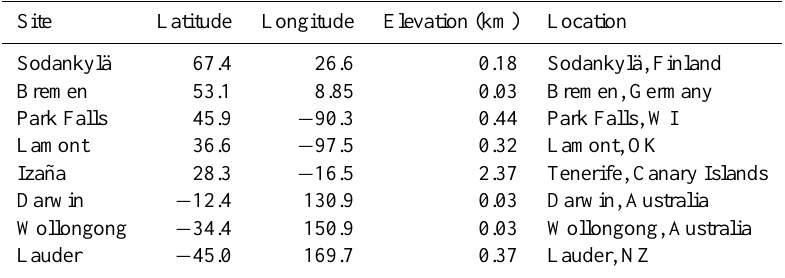
Figure 3. Validation of the tropospheric column-averaged CH 4 derivation using HF as a proxy. The calculated tropospheric CH 4 ( y axis) uses the TCCON priors, CH 4 averaging kernel and ACE-FTS vertical profiles to determine the value that the ground-based FTS would retrieve. The integrated tropospheric CH 4 ( x axis) applies the pressure-weighting function and TCCON CH 4 averaging kernel and priors to the extrapolated tropospheric ACE-FTS profile of CH 4 . The black lines depict the one-to-one line (solid) and the linear regression of the calculated vs. integrated tropospheric CH 4 with a zeroed y intercept (dashed). The r 2 values correspond to the linear regression. Note the different DMF ranges in the Northern vs. Southern Hemispheres. Table 2. TCCON sites, coordinates, altitudes, and locations used in this